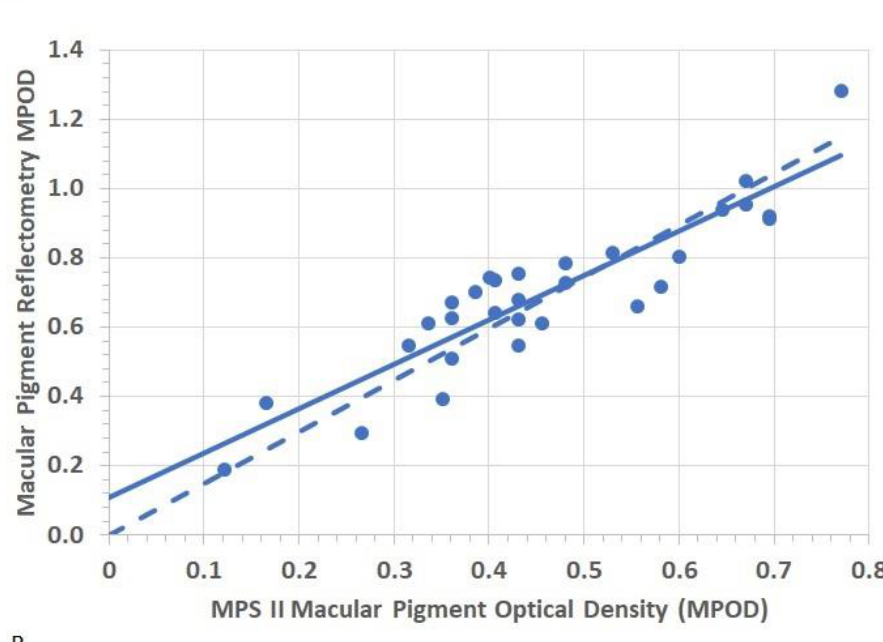
Figure 2. Shows bivariate linear regression analysis between the MPR- MPOD for 10–30 s time stamped interval data and MPS II-MPOD. The panel-( A ), represents MPR-MPOD obtained undilated (r = 0.906) and panel-( B ) represents MPR-MPOD obtained with dilated pupils (r = 0.910). The solid line is the regression line, and the dashed line is the zero-intercept, slope of one line.